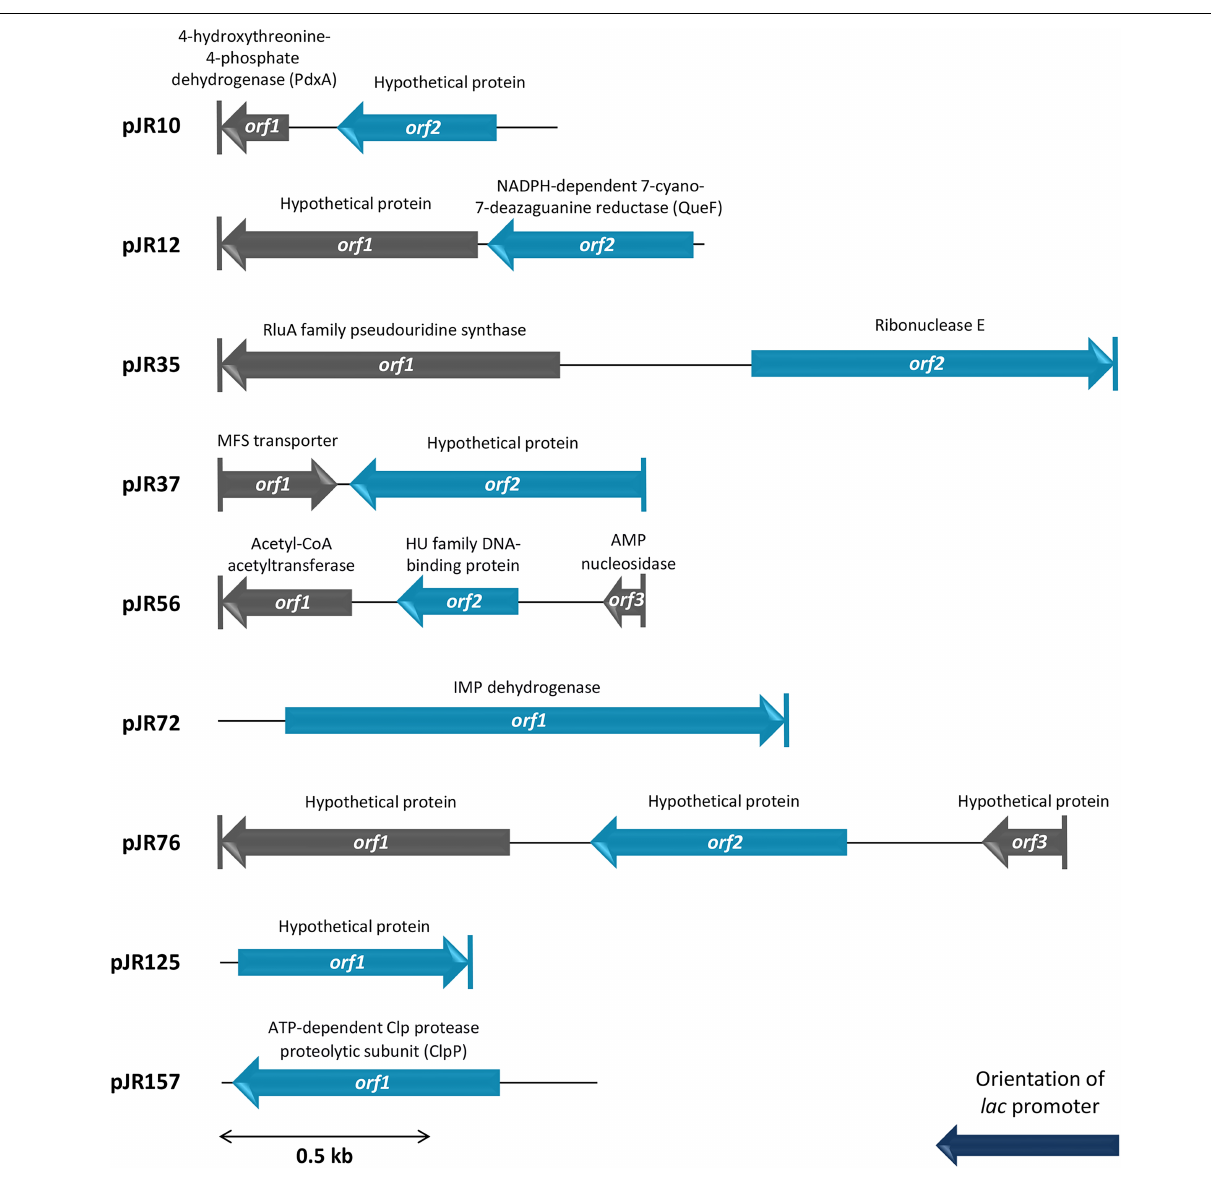
FIGURE 2 | Schematic organization of the predicted ORFs identified in plasmids pJR10 to pJR157. Arrows indicate the locations and the transcriptional orientation of the ORFs in the different plasmids. Those predicted ORFs involved in perchlorate resistance are denoted by blue arrows. Truncated ORFs are indicated by a vertical bar at the corresponding